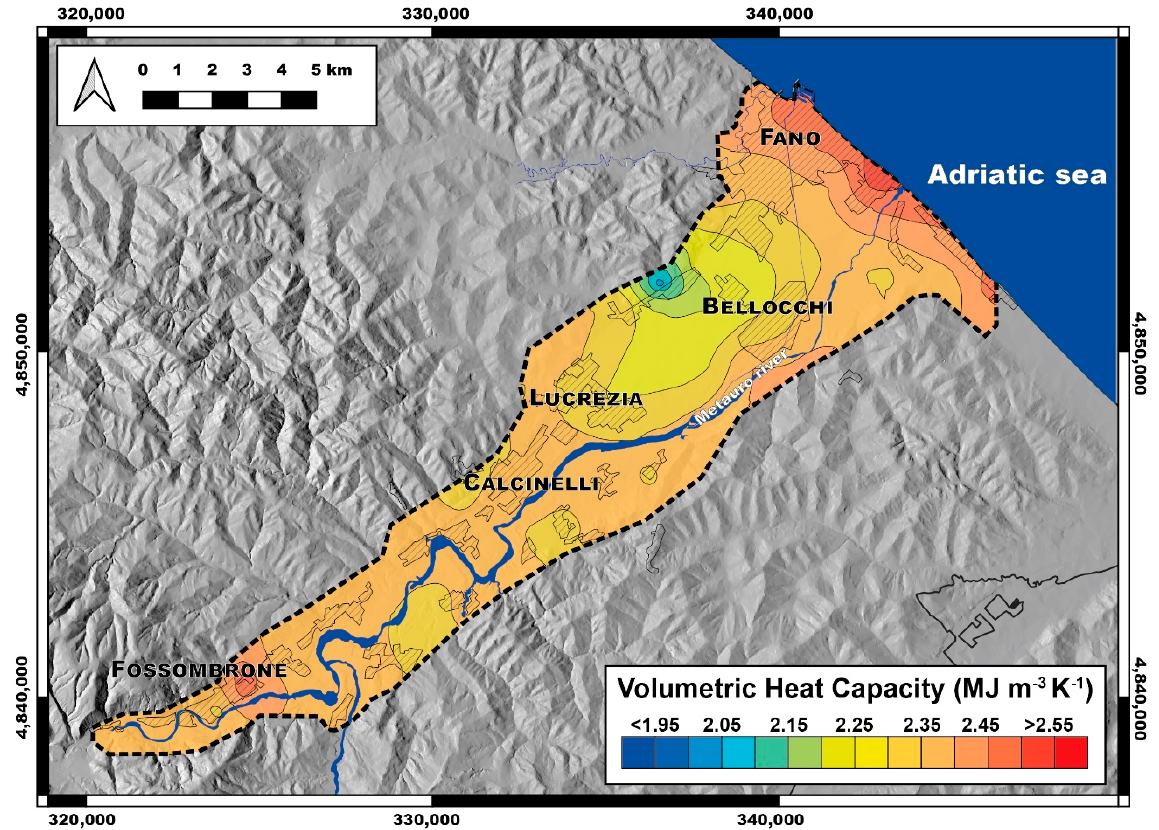
Figure 6. Map of the estimated volumetric heat capacity of the ground averaged over 100 m of depth from the surface.